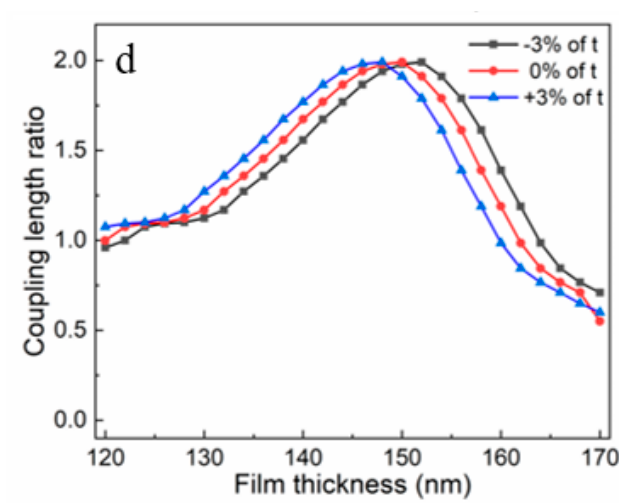
Figure 3. ( a ) Birefringence in the proposed PCF-PBS with and without the As 2 S 3 layer, as well as the effect of different PCF characteristic parameters on the coupling length ratio (CLR) for the proposed PBS. ( b ) The CLR versus normalized pitch when d 1 = 1.1 μ m, d 2 = 2.2 μ m, and t = 150 nm; ( c ) the CLR versus the relative diameter ratio when Λ = 2.2 μ m, d 1 = 1.1 μ m, and t = 150 nm; and ( d ) the CLR versus the As 2 S 3 layer thickness when Λ = 2.2 μ m, d 1 = 1.1 μ m, and d 2 = 2.2 μ m.